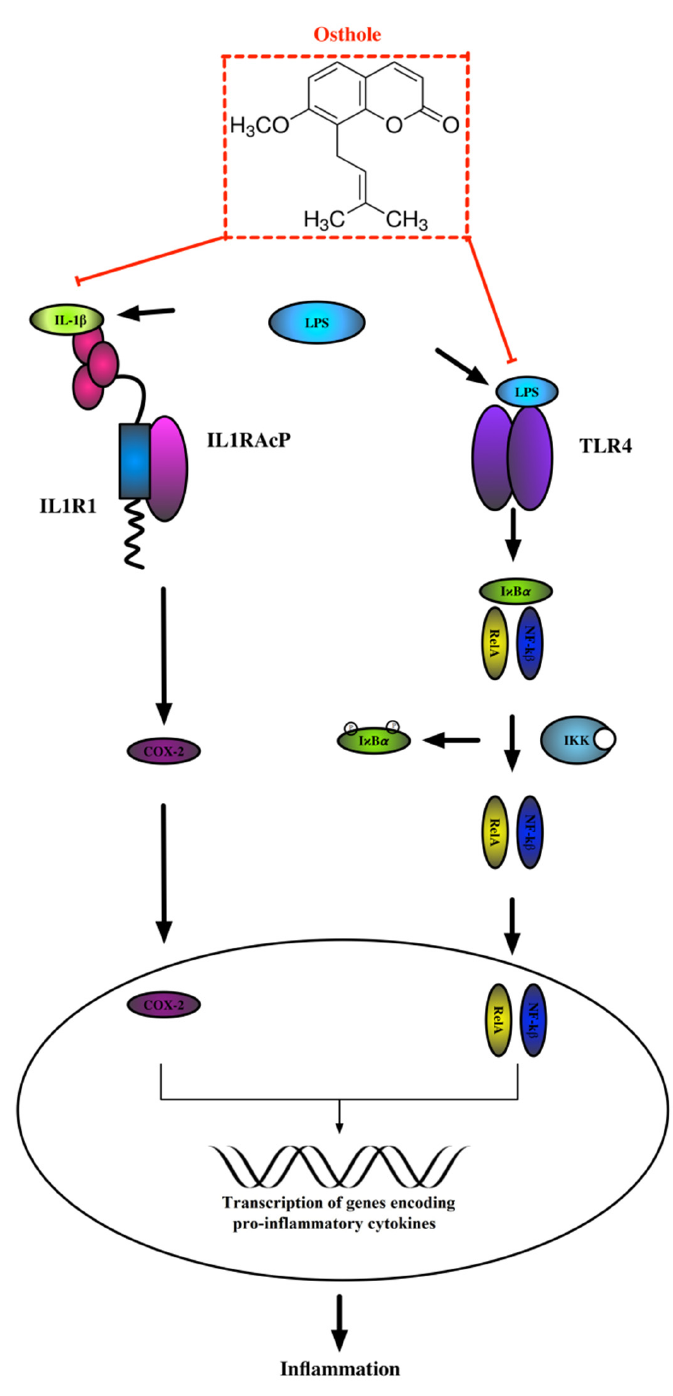
Figure 7. The scheme of LPS-induced inflammatory response.